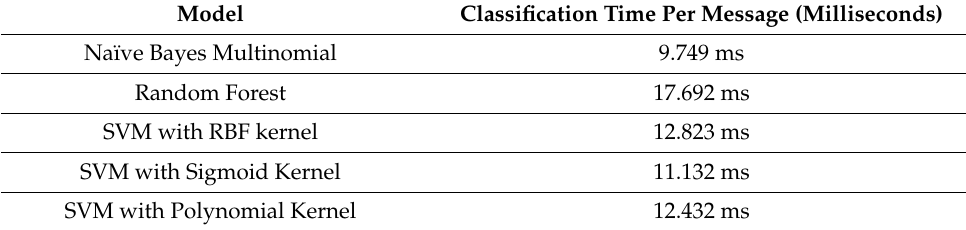
Table 3. Time required for